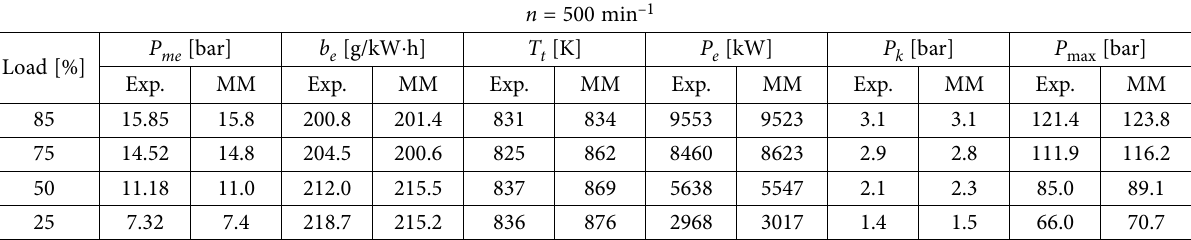
Table A5. Comparison of diesel engine MAN B&W 6S60MC MM adequacy validation experiment and modelling